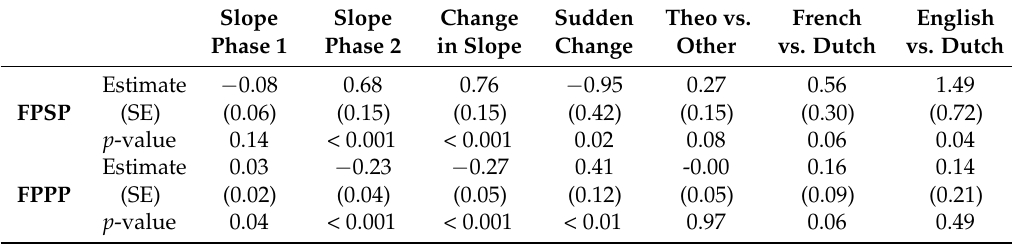
Table 1. Results from change-point analyses of the percentage of first person singular and plural pronouns (FPSP and FPPP, respectively) in Van Gogh’s letters. Slopes represent annual change in percentage of FPSP and FPPP use.